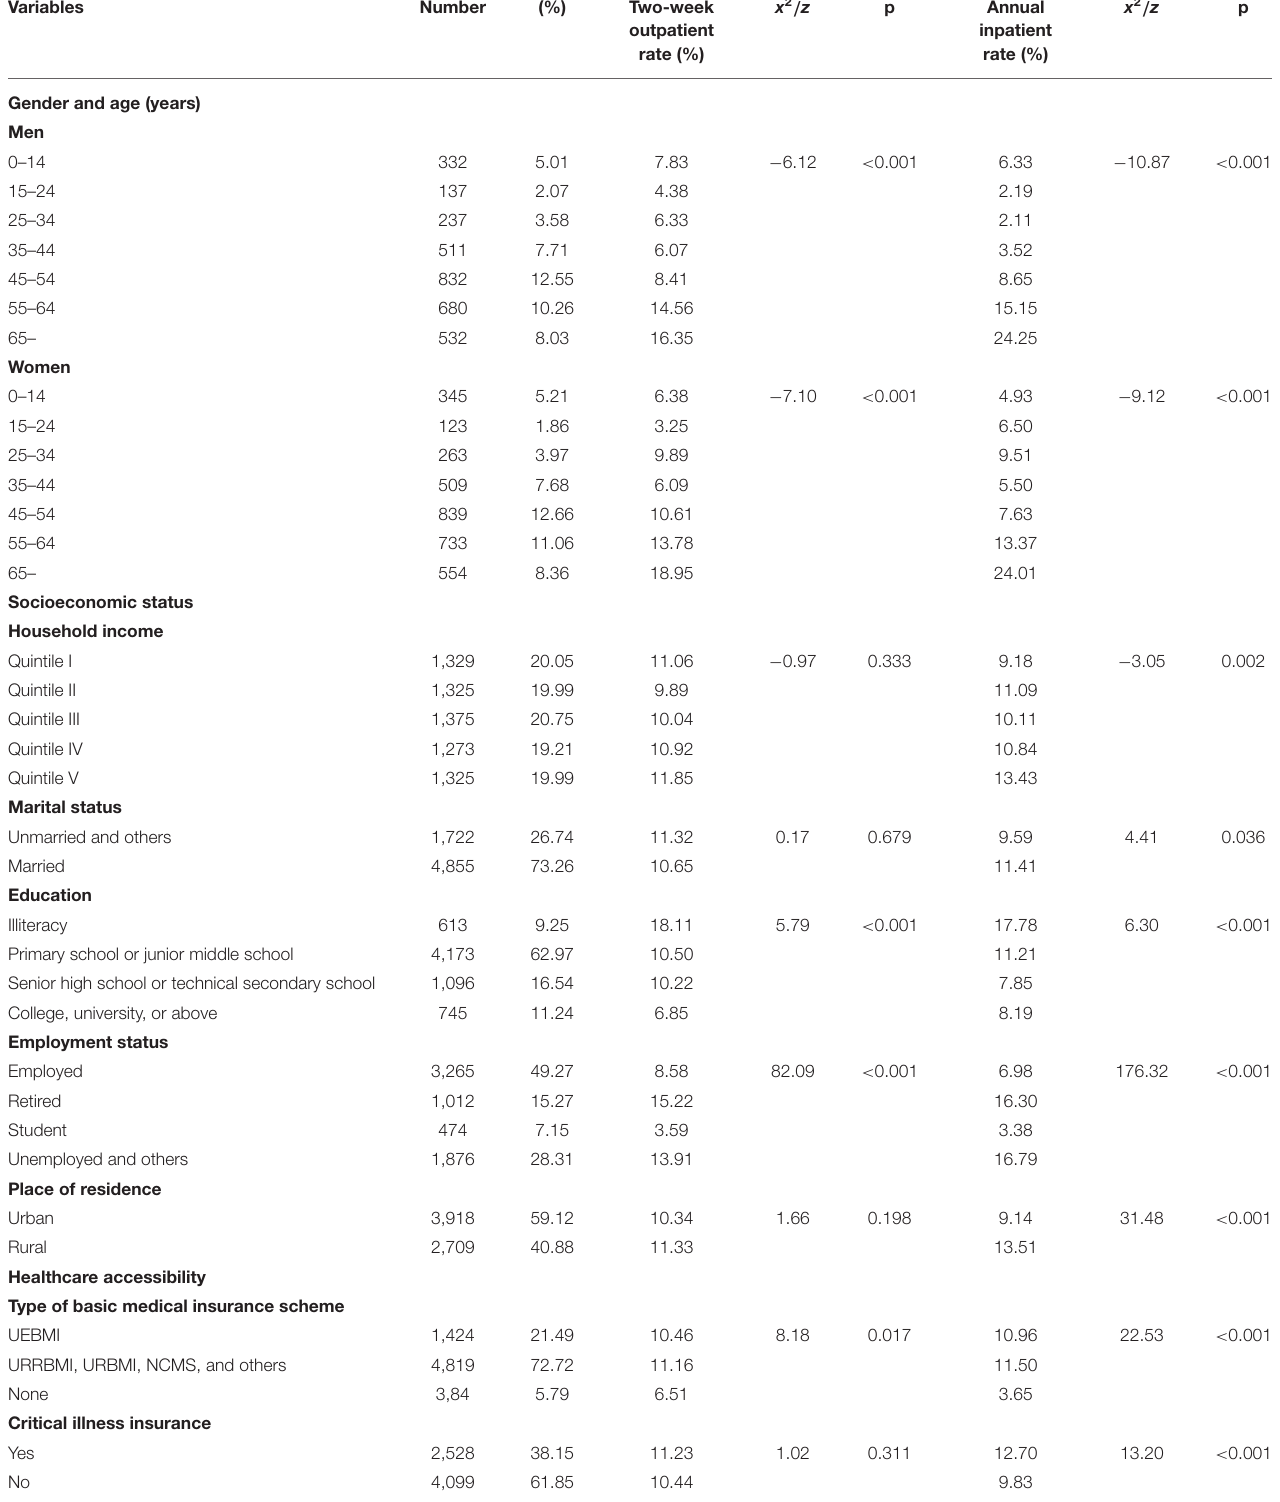
TABLE 1 | Social demographic characteristics, healthcare accessibility, health status, and health services utilization of